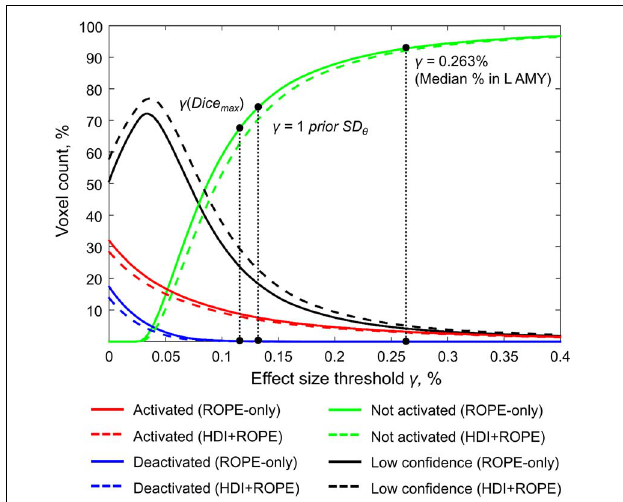
FIGURE 7 | Number of voxels classified into the four categories depending on the ES threshold γ . The results for the emotion processing task (‘Emotion > Shape’ contrast) are presented for illustration. L AMY, left amygdala. experimental conditions with baseline activity. For ‘moderate’ physiological effects, PSC varied in the range 0.1 − 0.2%, for